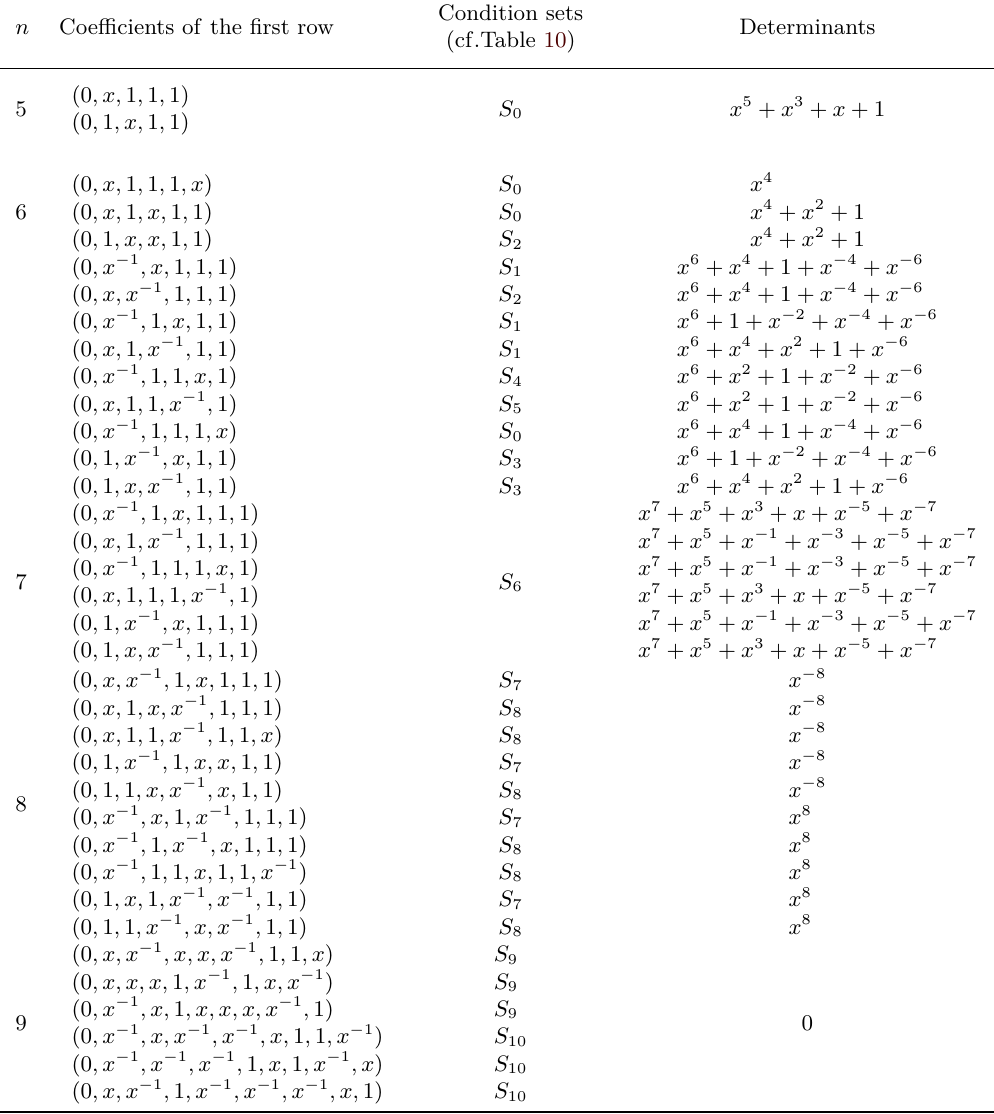
Table 9: List of generic near-MDS circulant matrices of order 5 ≤ n ≤